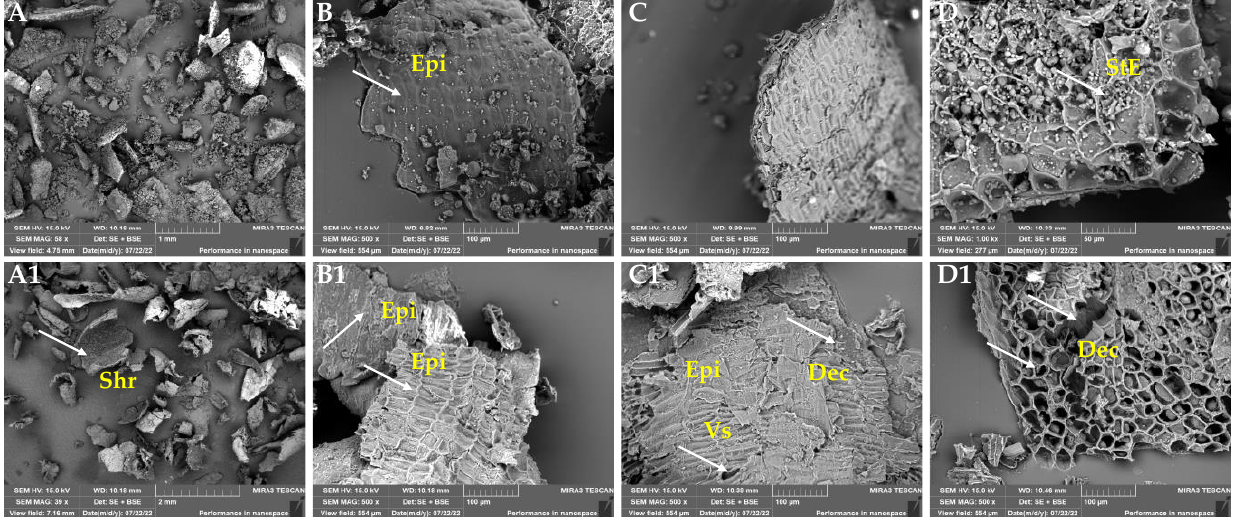
Figure 5. Scanning electron microscopy (SEM) images of untreated ( A , B , C , D ) and enzymatically hydrolyzed ( A1 , B1 , C1 , D1 ) rye bran samples. The hydrolysis was accomplished by cellulose-degrading commercial multi-enzyme complex Viscozyme L for 48 h. Note: white arrows indicate: smooth and homogeneous surface of bran epidermal layer ( B ); two fractions of starch granules embedded into starchy endosperm matrix ( D ); visible signs of bran shrinkage and twisting ( A1 ); visible shrinkage of bran epidermal layer ( B1 ); cracking (irregular void spaces) and partial decomposition of epidermal layer; tangible decomposition of the epidermal layer and ellipse-shaped void spaces of 40 – 50 µm in diameter with no starch granules ( D1 ). Epi — epidermal layer; StE — starchy endosperm; Shr — shrinkage; Dec — decomposition; Vs — void spaces.